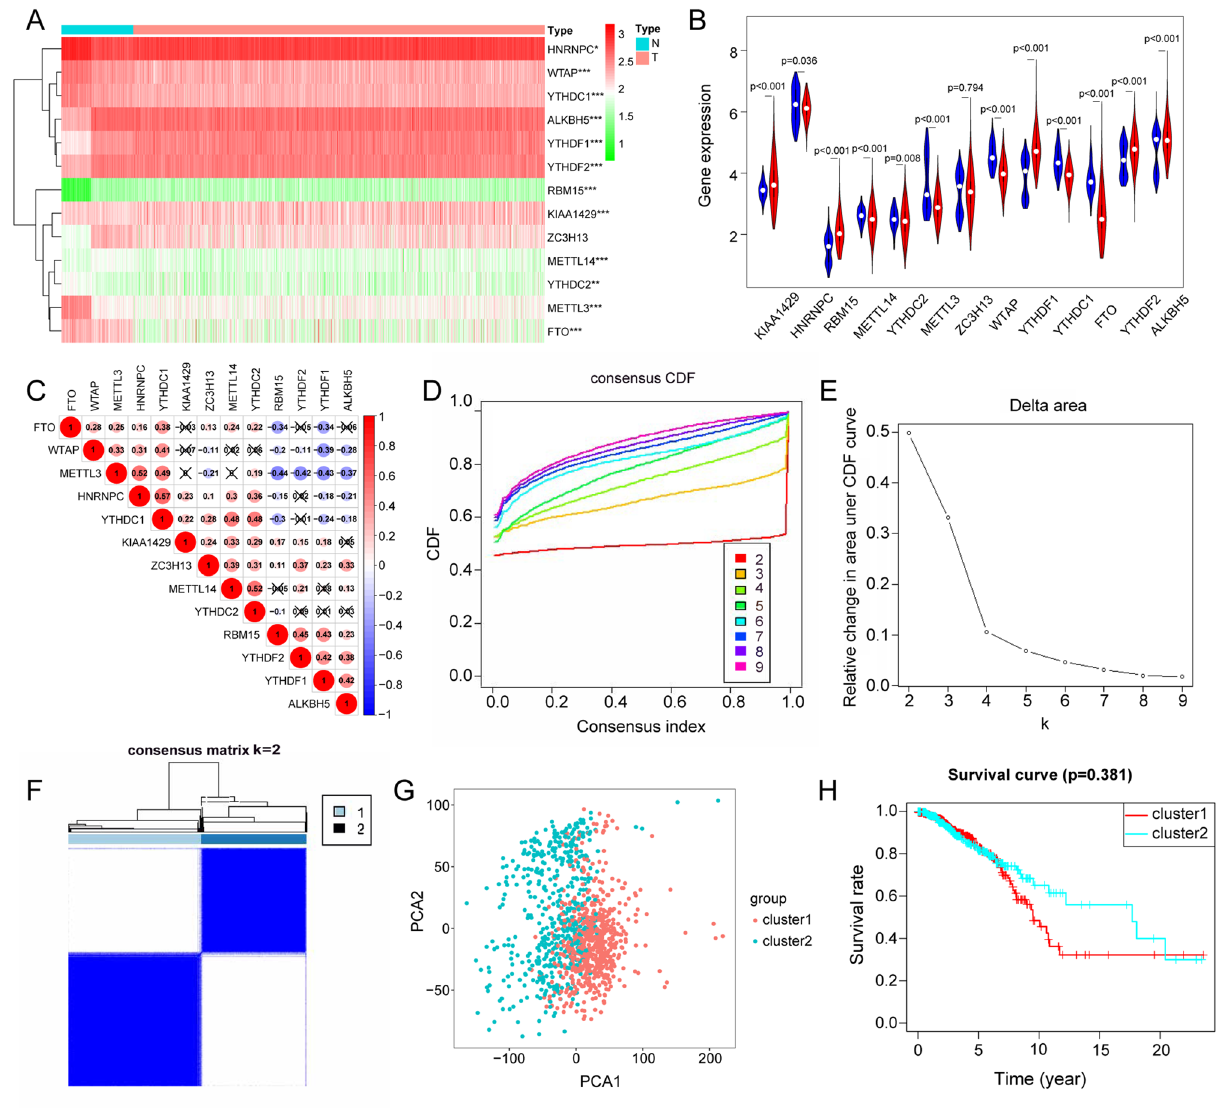
Figure 2. The expression of m6A regulator genes and clustering of samples. ( A ) Differential heatmap of 13 m6A regulator genes in breast cancer. Red indicates upregulation, and green indicates downregulation. Blue represents normal tissue and red represents breast cancer tissue. *P < 0.05, **P < 0.01, ***P < 0.001. ( B ) A violin plot of differential expression of 13 m6A regulator genes in breast cancer. Blue represents normal tissue and red represents breast cancer tissue. ( C ) Correlation analysis of m6A regulator genes. Red represents positive correlation, blue represents negative correlation. ( D–F ) Identification of consensus clusters by 13 m6A regulator genes. ( D ) The consensus cumulative distribution function (CDF) of the consensus matrix for each K (colored). ( E ) The Delta area diagram shows the relative change of area under the CDF curve. ( F ) The consensus matrix displays the cluster membership marked by colored rectangles, enabling users to calculate the number of cluster members in their consensus context. ( G ) Reliability analysis of tumour consensus clusters. Red represents cluster 1 and blue represents cluster 2. ( H ) Survival analysis of two tumour clusters. Red represents cluster 1 and blue represents cluster